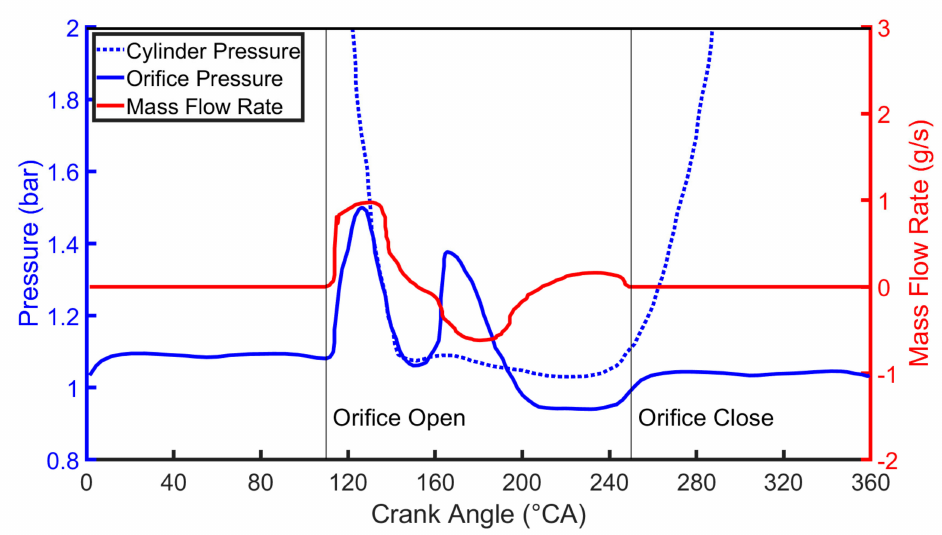
Figure 6. Pressure and mass flow curves of the connecting orifice in a single cycle